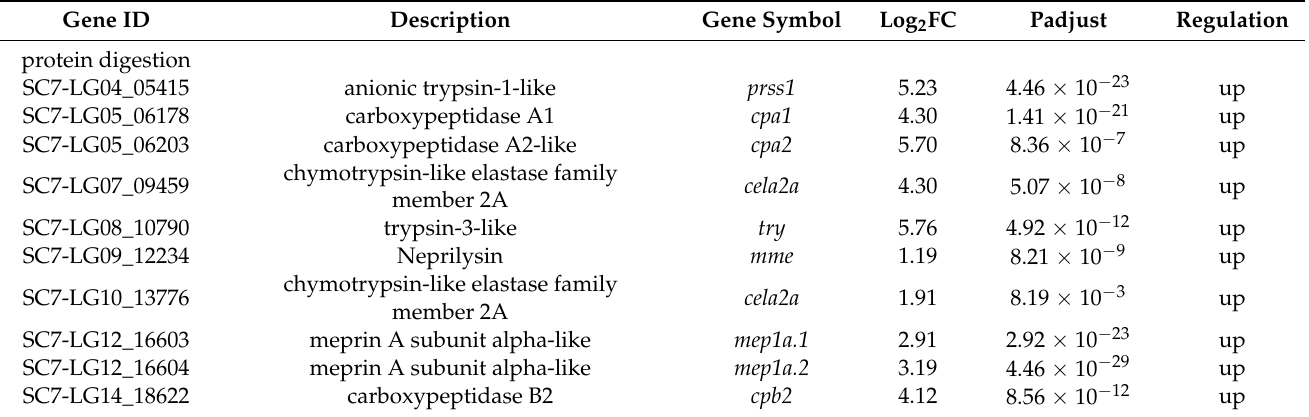
Table 4. Representative DEGs between the mandarin fish larvae unfed and fed with brine